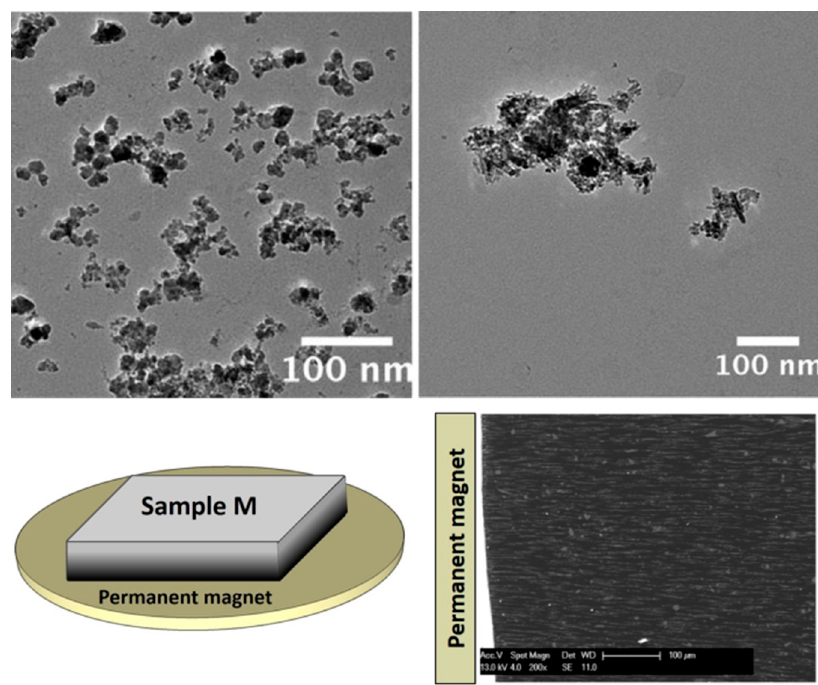
Figure 4. TEM images of bare magnetite NPs ( top left ) and Fe 3 O 4 @TiO 2 NPs ( top right ) used to prepare anisotropic NCs. Reprinted from the work of [41] with permission from Elsevier; ( bottom left ) sketch of the setup used to produce anisotropic magnetic NCs; ( bottom right ) micrometer-sized chains, which have been aligned along the direction of magnetic flux lines. Reprinted in modified form from the work of [41] with permission from Elsevier.